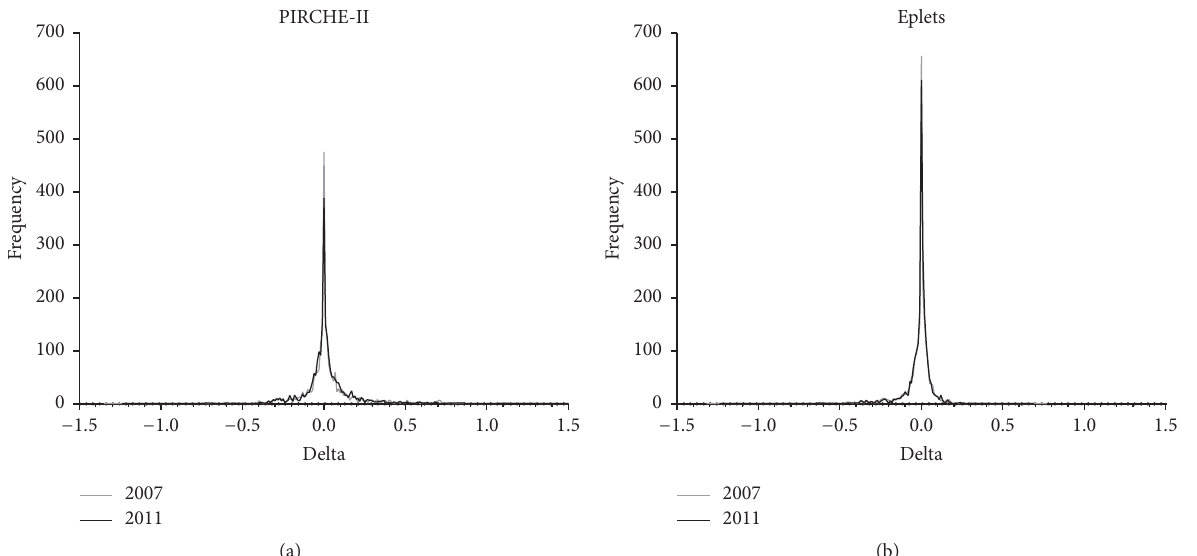
Figure 1: Deviation of the observed ln(PIRCHE-II)/ln(eplet) values from reference ln(PIRCHE-II)/ln(eplet) values when using HLA haplotype frequency tables from 2007 or from 2011. For both ln(PIRCHE-II) (a) and ln(eplet) (b), the observed values do not deviate or only slightly deviate from the reference values. The use of haplotype HLA frequency tables from 2007 (gray line) or from 2011 (black line) resulted in similar